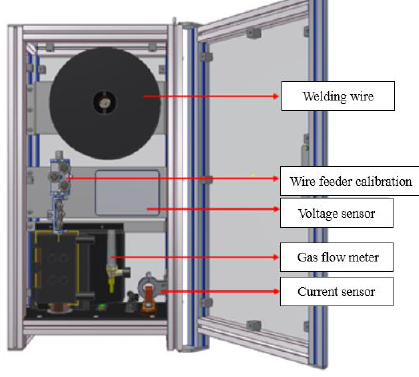
Figure 2. Automatic welding equipment in the pipeline system.